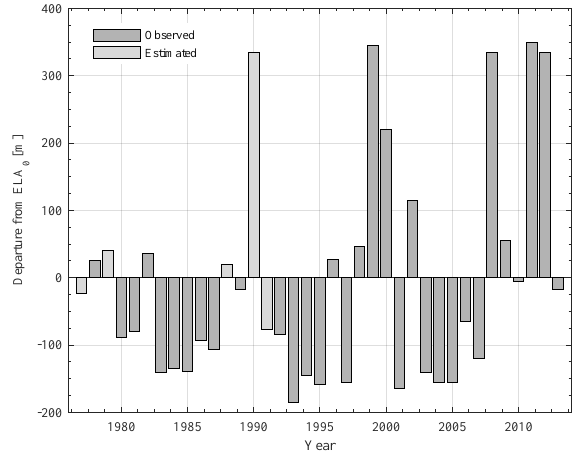
Figure 4. Record of the EOSS programme SLA departures from ELA 0 = 1935m for Brewster (Willsman et al.,